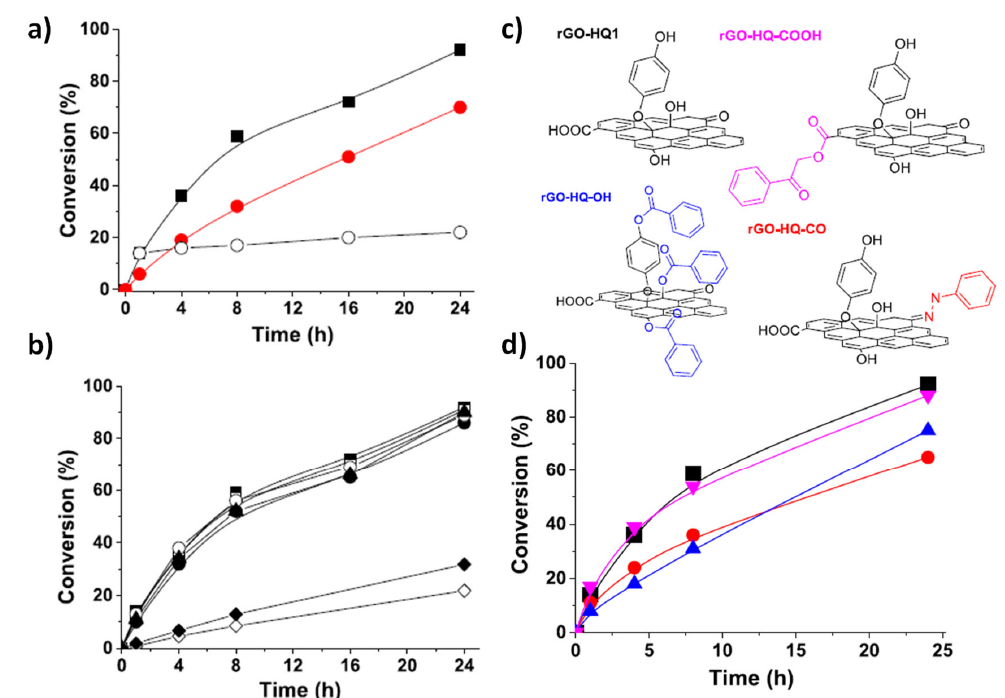
Figure 9. ( a ) Time conversion ‐ plot for the aerobic oxidation of benzylamine using rGO ‐ HQ1 ( ■ ), rGO ‐ HQ2 ( ● , red) and after hot filtration test using rGO ‐ HQ1 ( ○ ); ( b ) reusability of rGO ‐ HQ1 (first ■ , second □ , third ○ , fourth ▲ , fifth ● ) and catalytic activity of manganese(II) acetate (0.6 ◊ or 2 ⧫ mg of Mn(II) equivalent to 30 or 100 ppm of Mn(II) in the solid catalyst). ( c ) Selective masking of oxygen ‐ functional groups present in the rGO ‐ HQ1 sample including carboxylic groups (rGO ‐ HQCOOH), carbonyls (rGO ‐ HQ ‐ CO) or alcohols (rGO ‐ HQ ‐ OH). ( d ) Time ‐ conversion plots for the aerobic oxidation of benzylamine using rGO ‐ HQ1 ( ■ ), rGO ‐ HQ ‐ COOH ( ▼ , pink), rGO ‐ HQ ‐ CO ( ● , red) or rGO ‐ HQ ‐ OH ( ▲ , blue) as carbocatalysts. Reaction conditions: benzylamine (1 mL), catalyst (20 mg), oxygen purged, 80 °C. Reprinted with permission from reference [131].